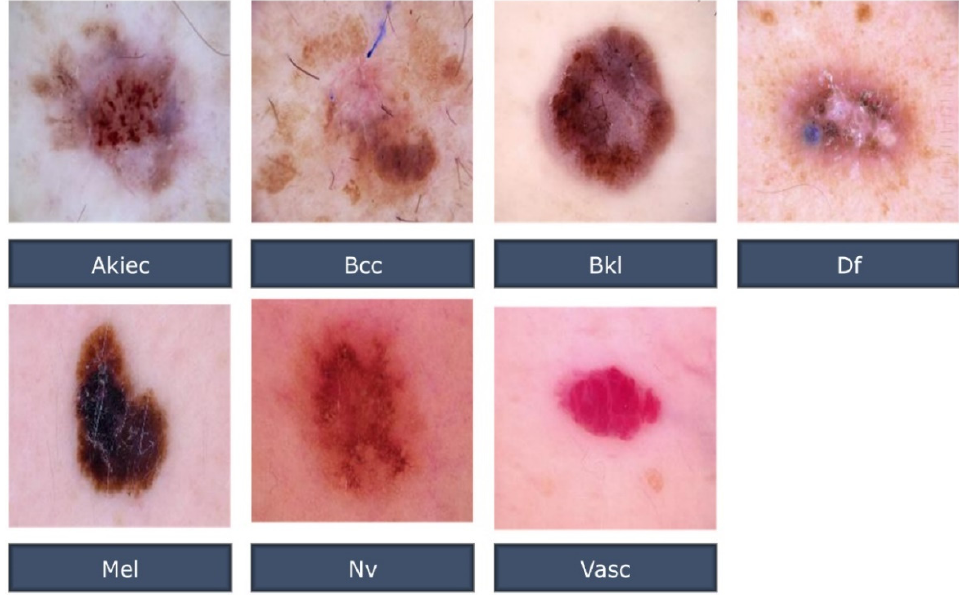
Figure 2. Examples of HAM10000 Dataset.